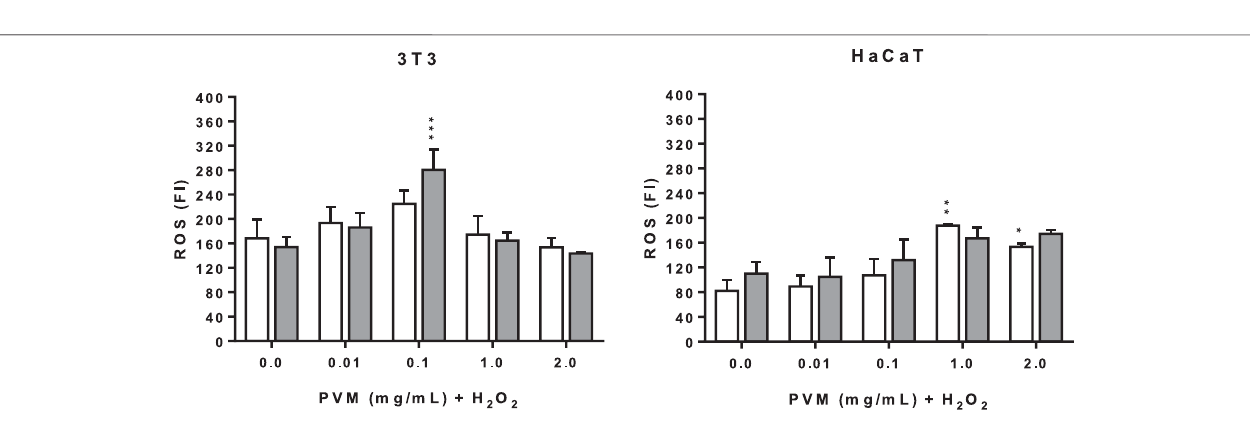
FIGURE6| IntracellularROSinducedby1and2 mM H 2 O 2 for2 h treatment withPVMin 3T3andHaCaT cells. H 2 O 2 : positivecontrol. White columns correspond to 1 mM H 2 O 2 and gray columns correspond to 2 mM H 2 O 2 . Results are expressed as mean ± standard error of n (cid:2) 3. A two-way analysis of variance (ANOVA) and a Bonferroni post hoc assay have been performed. Statistical differences were considered as follows: * p ≤ 0.05, ** p ≤ 0.01 and *** p ≤ 0.001 compared with the correspondent positive control.